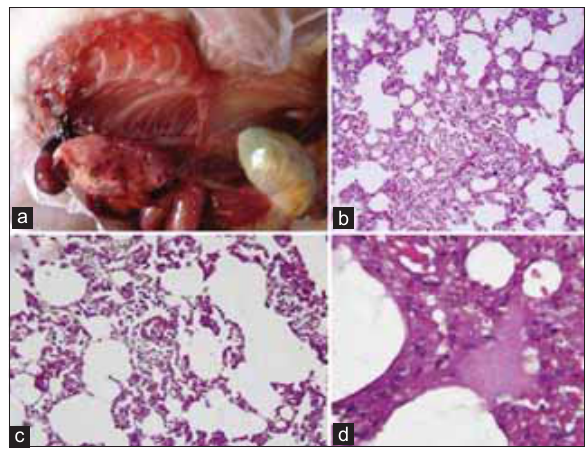
Figure-2: (a) Echymotic hemorrhages in 25 mg/kg group, (b) Mild congestion and thickening of alveolar septa in 25 mg/kg group, (c) In 100 mg/kg group bronchi of rats filled with mononuclear cells and red blood cells, emphysema and thickening of alveolar septa, (d) Severe hemorrhages and edema in lungs of rats of 200 mg/kg